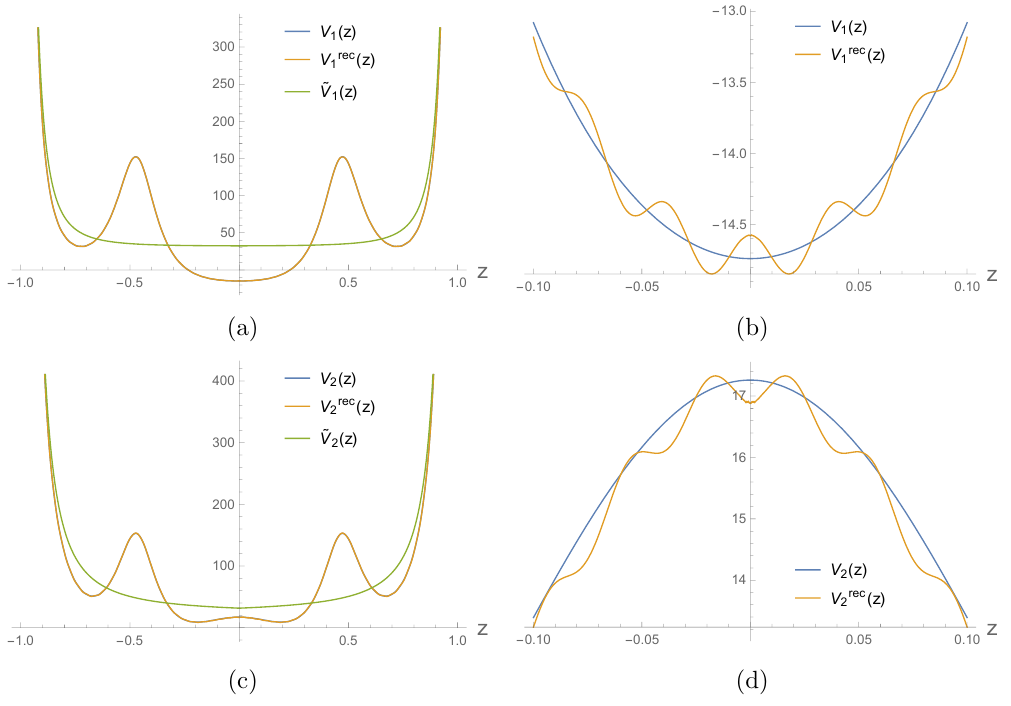
Figure 3. True potentials V i ( z ) (computed by equation (3.55) with ˜ a ( z ) given by (3.54)), recon- structed potentials V rec